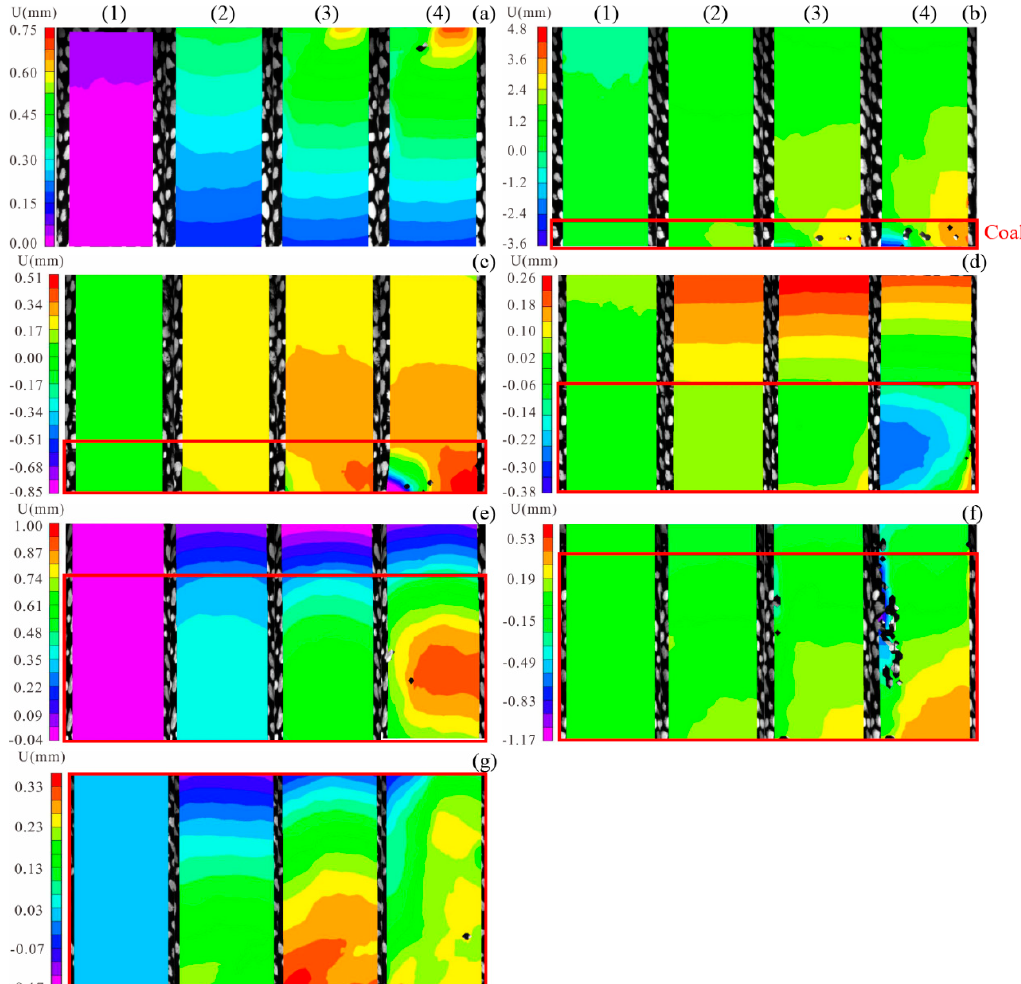
Figure 8. Evolution cloud map of lateral displacement field for combination: ( a ) AS-2, ( b ) CAS-a1, ( c ) CAS-b2, ( d ) CAS-c2, ( e ) CAS-d3, ( f ) CAS-e3, ( g ) C-2; (1), (2), (3), and (4) are the compaction stage, elastic stage, yield stage, and post-peak stage, respectively. Coal is inside the red box, and rock is outside of the red box. The negative value in the ruler indicates the direction to the left, while the positive value indicates the direction to the right.